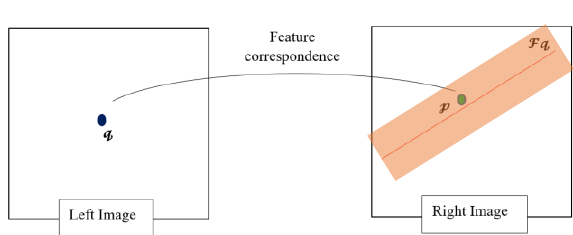
Figure 3. Epipolar constraints in the presence of errors. A feature point in the left image is mapped to the estimated epipolar line which lies close to the actual corresponding feature point in the right